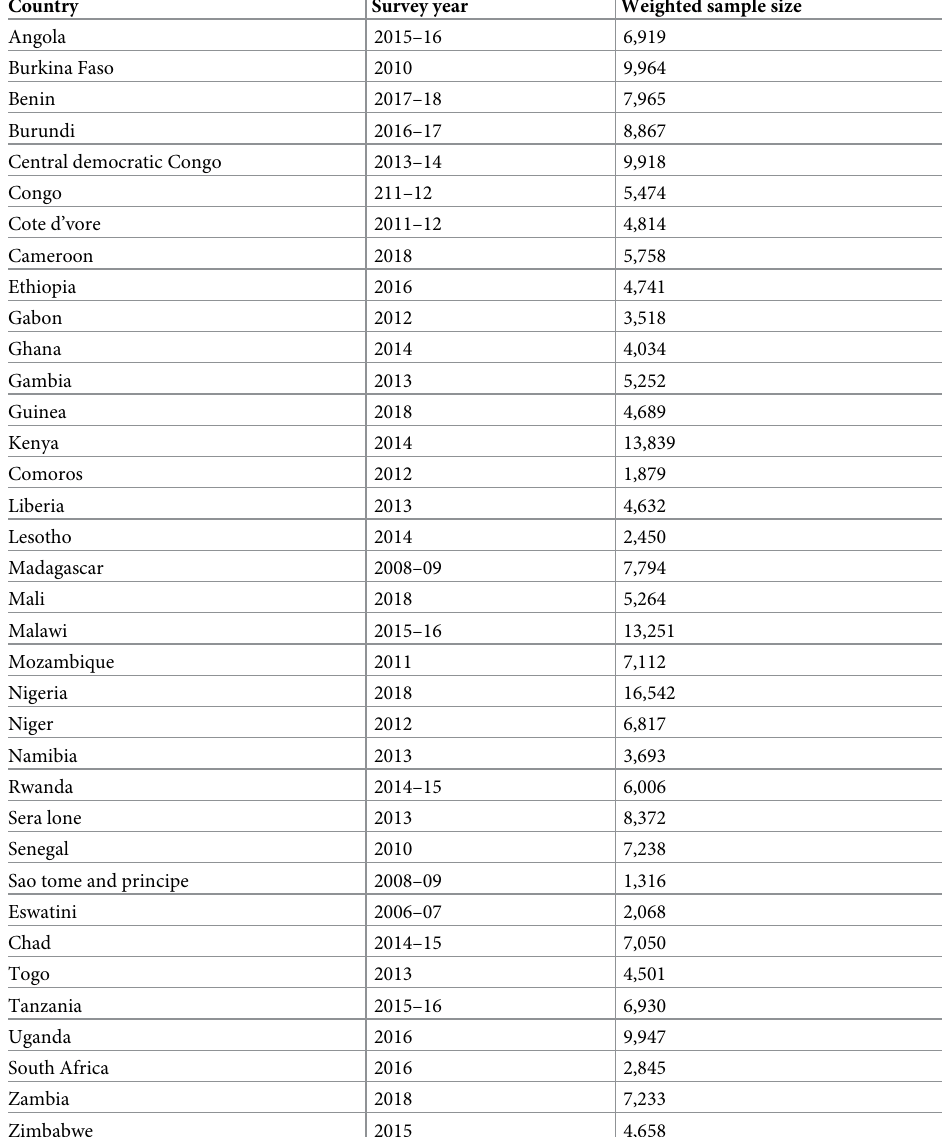
Table 1. Countries, survey year, and samples of Demographic and Health Surveys included in the analysis for 36 sub-Saharan African countries. Country Survey